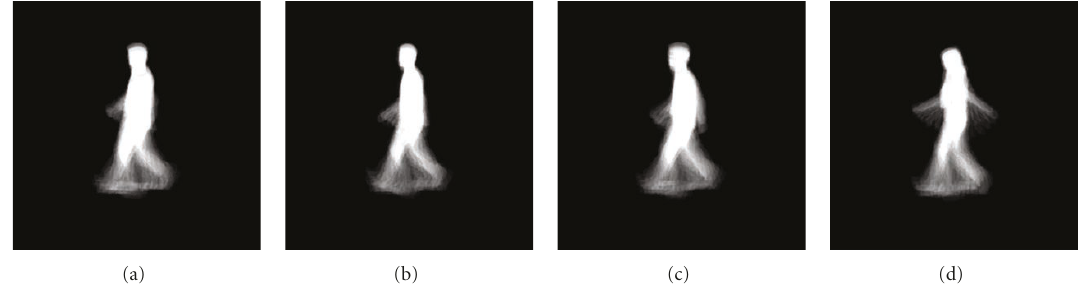
Figure 13: The extracted AME images in our experiments.